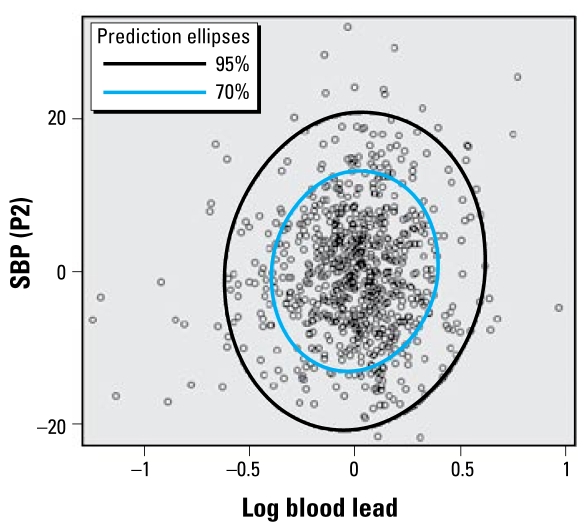
Scatterplot of the residuals for maternal blood lead and SBP between 24 and 36 weeks (P2) after controlling for the effect of variables listed in the logistic model in Table 3: correlation between residuals of the linear regression of the two variables on the partialed variables. In the 95% and 70% prediction ellipses, the major axis length is significantly larger than the minor axis length, indicating a partial correlation between maternal blood lead and SBP at P2.